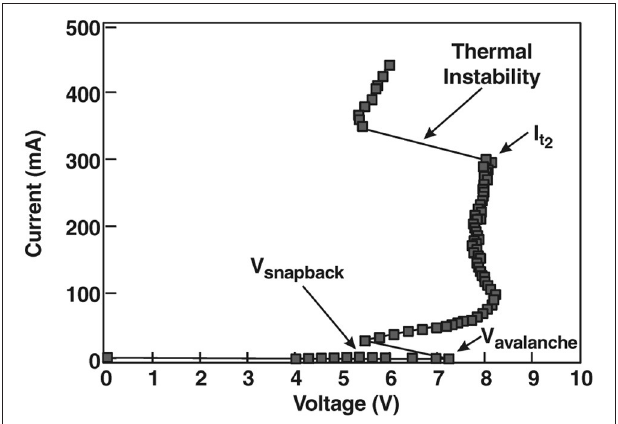
FIGURE 16 | FinFET device (with permission from John Wiley and Sons Ltd).